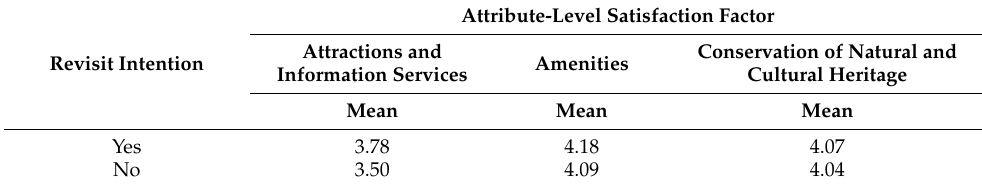
Table 7. Descriptive statistics according to revisit intention.